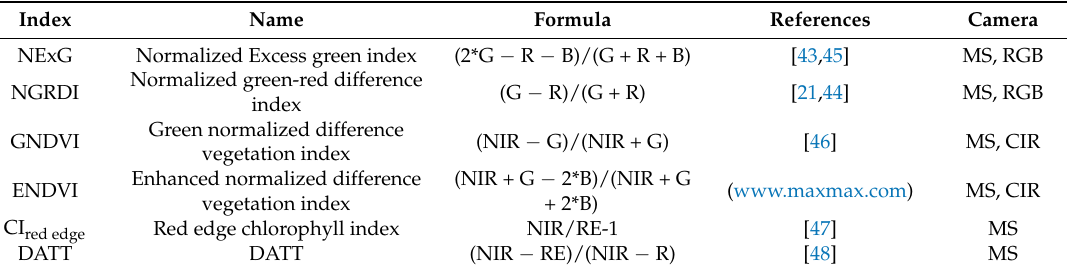
Table 3. Spectral vegetation indices evaluated in this